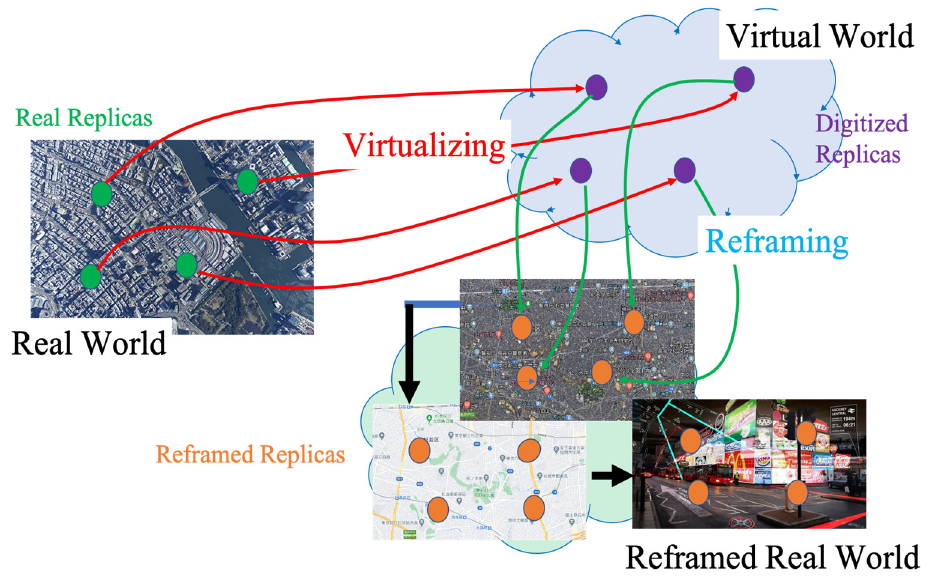
Figure 4. A V/R Twin Model for Google Maps.